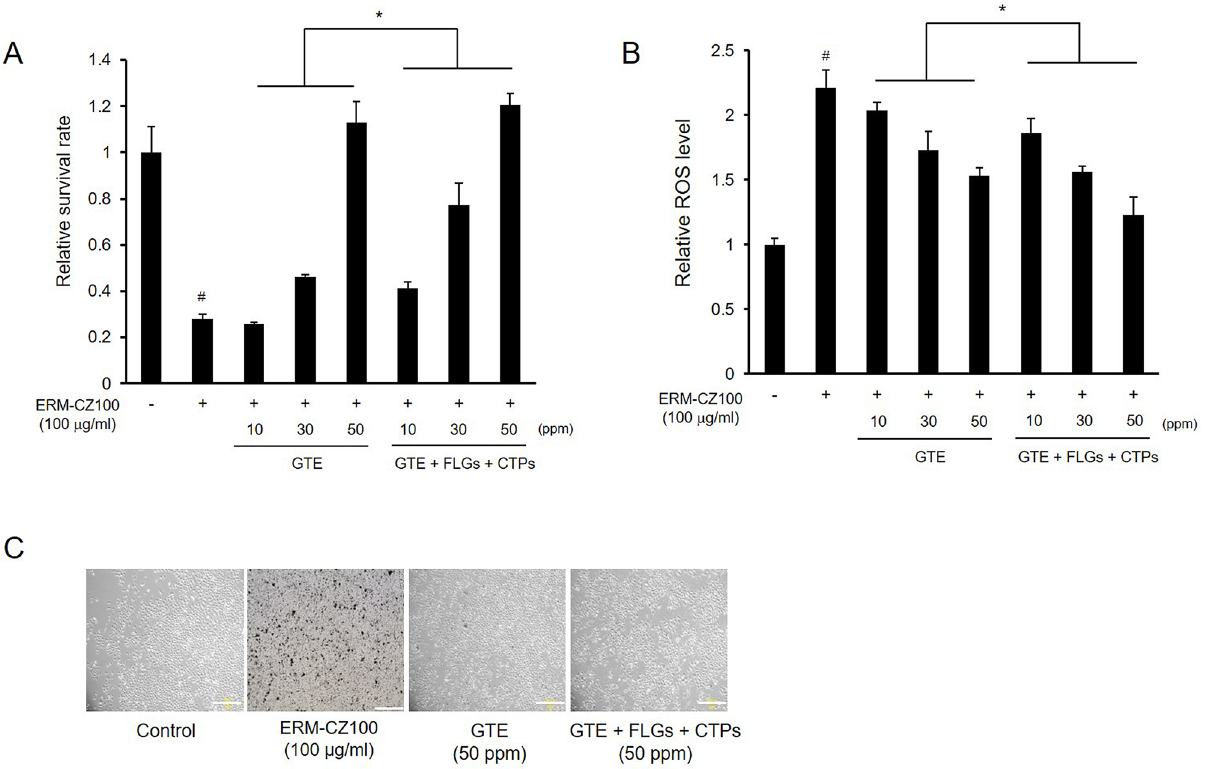
Figure 4. Protective effects of GTE, FLGs, and CTPs against FDP-elicited cellular damage. ( A ) Protective effects of GTE, FLGs, and CTPs on cell survival in FDP-stimulated BEAS-2B cells. ( B ) Protective ROS-scavenging effects of GTE, FLGs, and CTPs against FDP-induced oxidative stress. ( C ) Effects of GTE, FLGs, and CTPs on the morphology of FDP-treated BEAS-2B cells. The data are presented as the mean ± SD (N = 6). * p < 0.05 compared to the component alone treatment with combined treatment; # p < 0.001 compared to the vehicle control group. Scale bars, 200